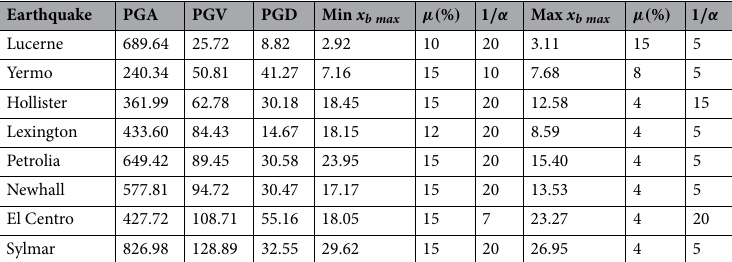
Table 4. Isolation system parameters that give smallest max. base